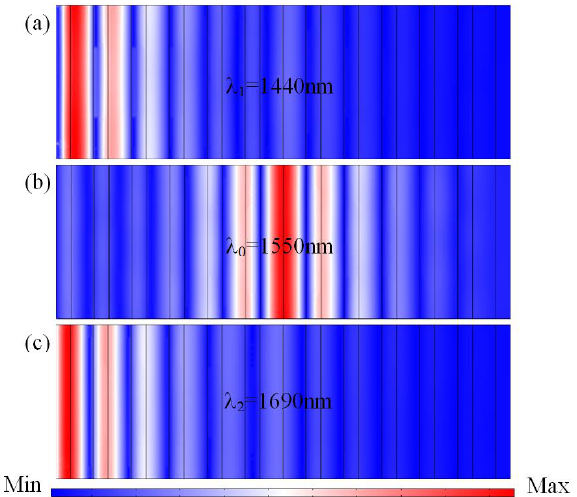
Figure 5. Simulated electric field distributions of the proposed quasi-one-dimensional PC-based NBF with (Nb 2 O 5 /SiO 2 ) 6 (SiO 2 /Nb 2 O 5 ) 6 at different wavelengths: ( a ) λ 1 = 1440 nm; ( b ) λ 0 = 1550 nm; and ( c ) λ 2 = 1690 nm.